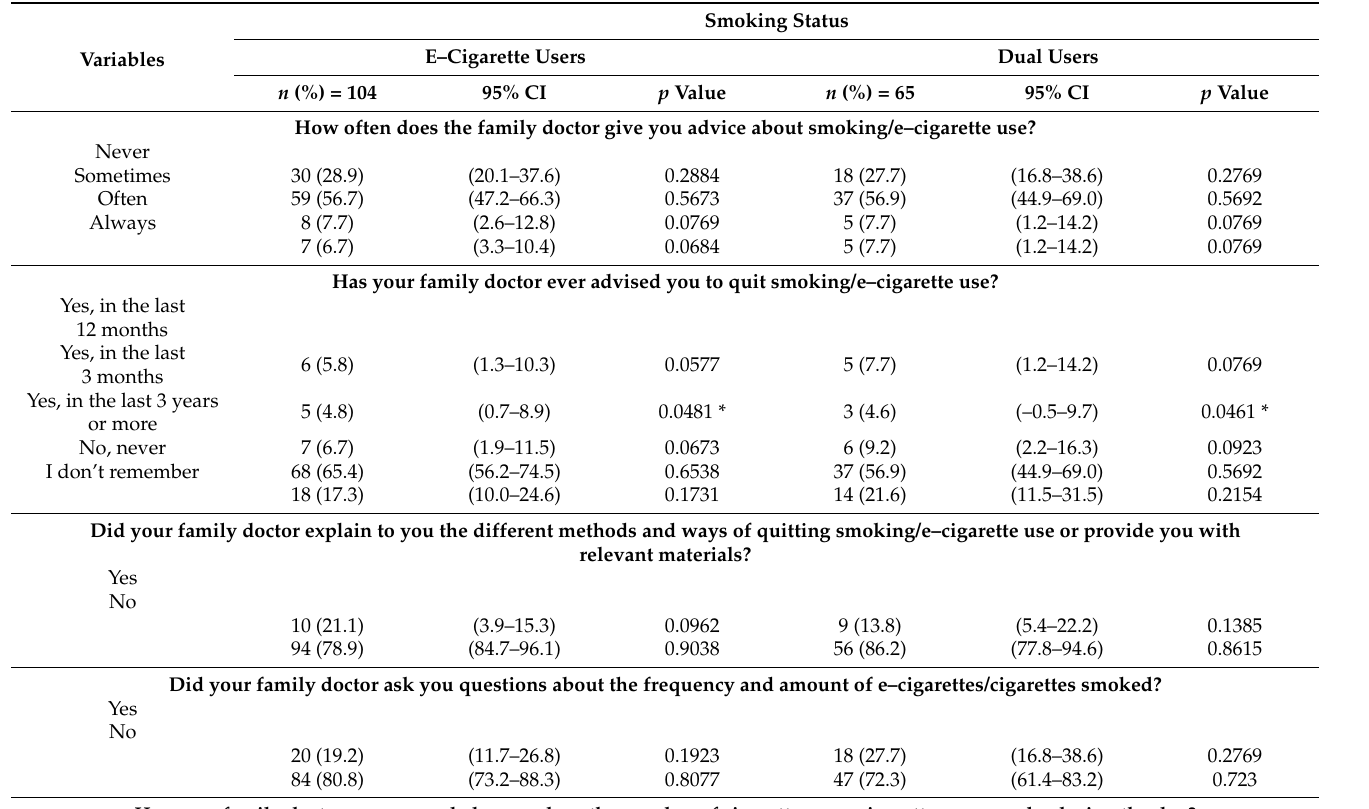
Table 4. Anti-tobacco counseling provided by a family doctor for e-cigarette users and dual